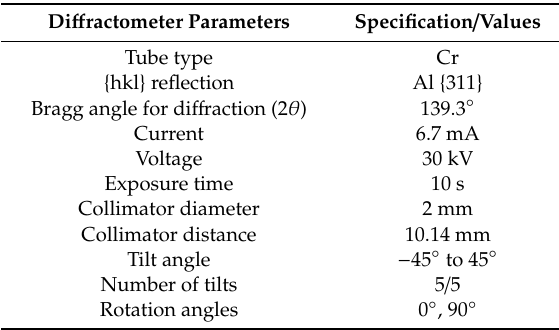
Table 4. The X-ray di ff ractometer parameters.